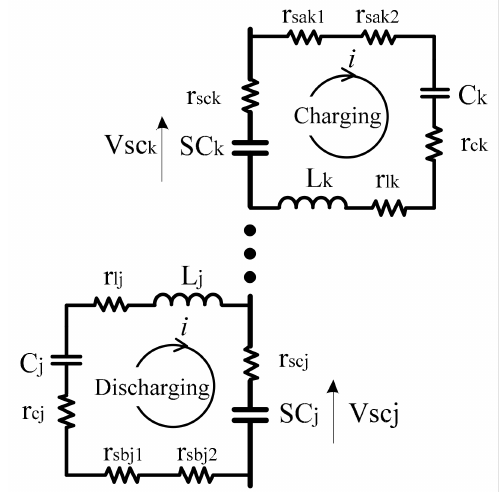
Figure 5. Circuit of ZCS